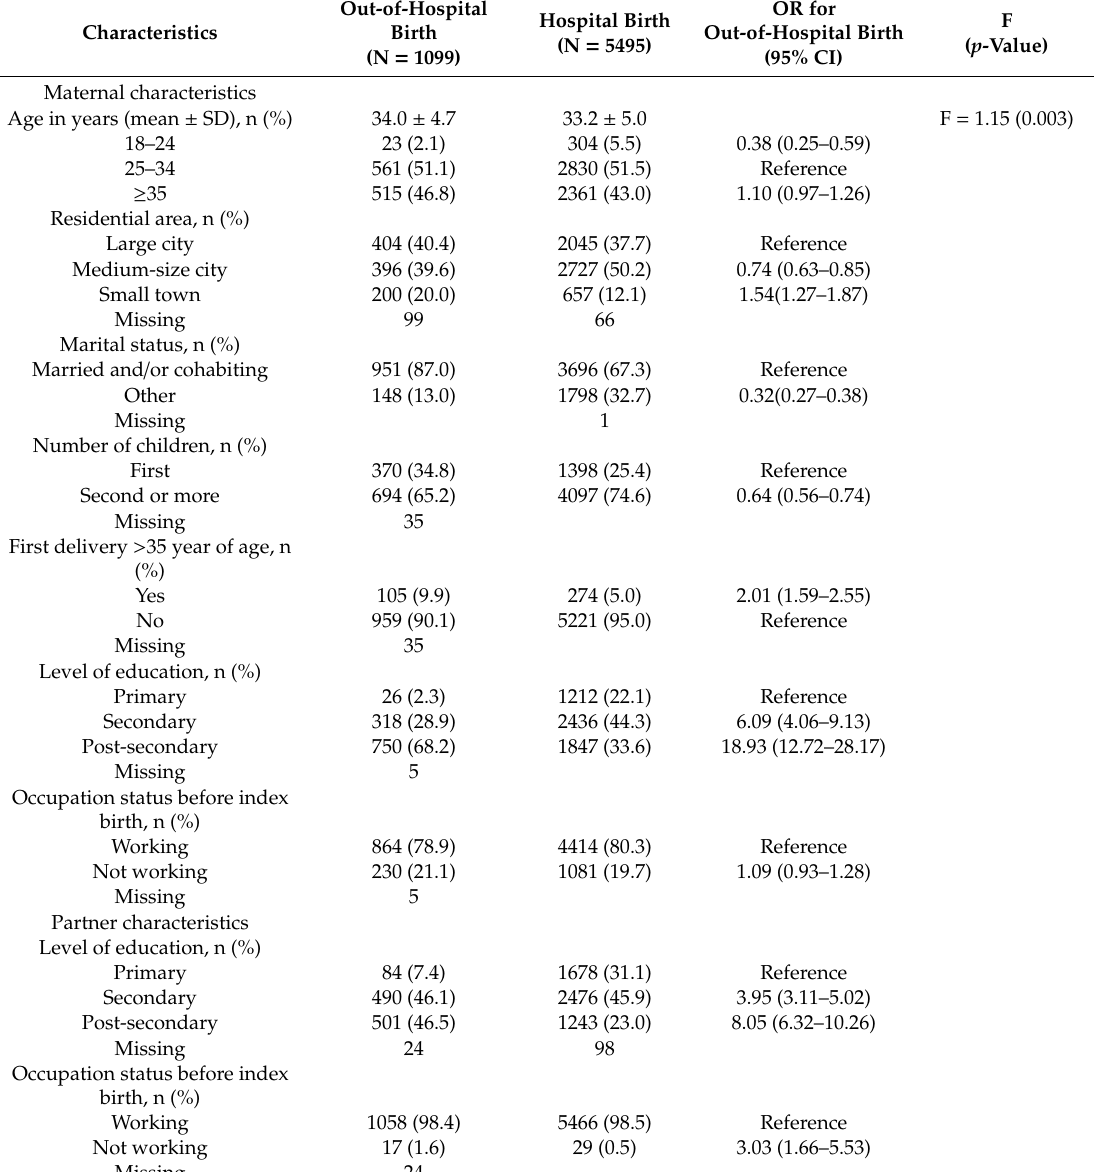
Table 4. Maternal and partner characteristics, by out-of-hospital and in hospital